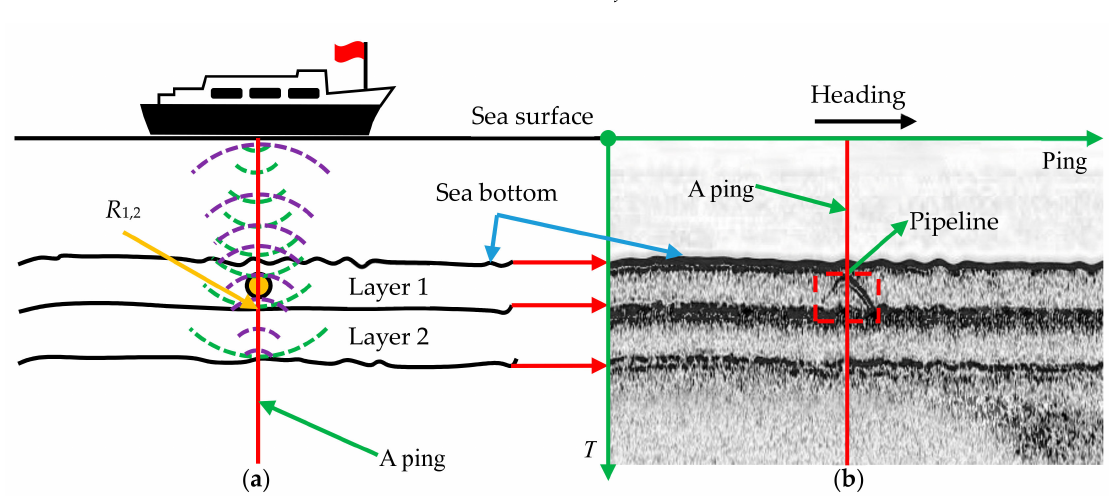
Figure 1. SBP working principle. ( a ) Echo signal generation process; ( b ) measured SBP waterfall image with a pipeline